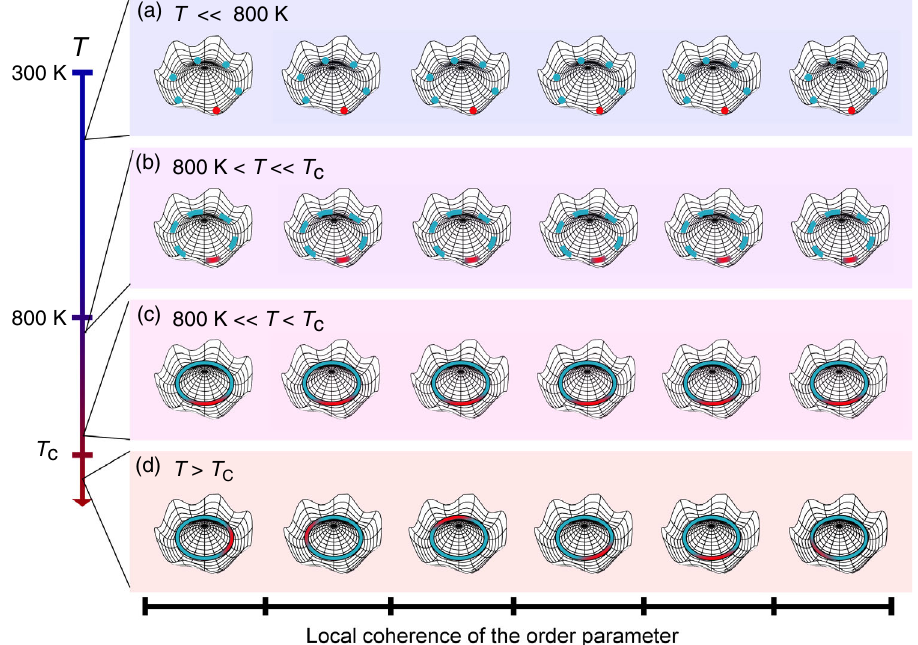
FIG. 7. Unconventional order-disorder transition of YMnO 3 . Local value of the order parameter in different temperature regions [panels (a) – (d)] within one domain. The blue lines indicate states accessible to the order parameter, and the red colored markings show the distribution of the order parameter. (a) In the low-temperature region, the order parameter is firmly fixed within one of the six ground states. (b) Between 800 K and T , fluctuations smear out the local distribution of the order-parameter angle (red), but the average angle C within each domain remains constant. (c) Close to T , the energy landscape flattens. (d) At and above T , coherence of the order C C parameter is lost and the system disorders between all possible states in the Mexican